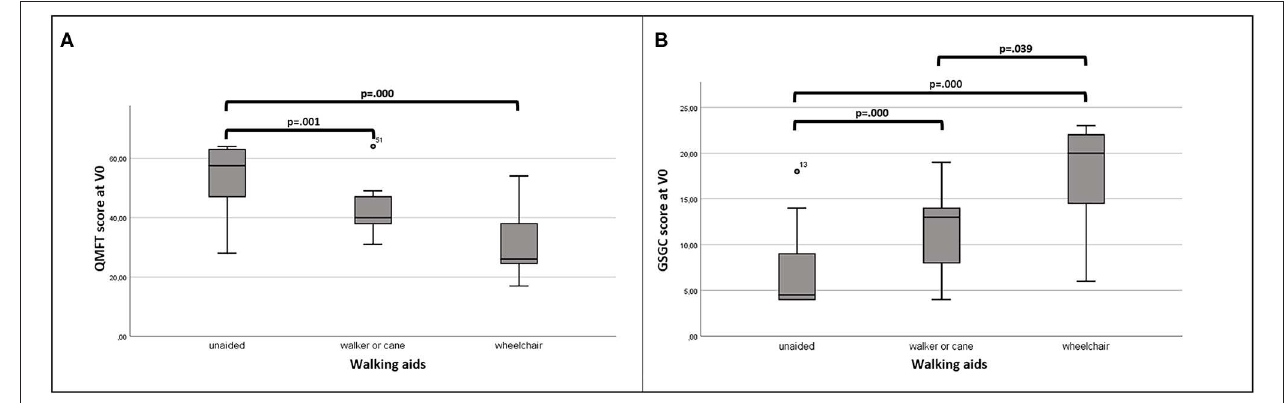
FIGURE 2 | Discrimination validity of QMFT (A) and GSGC (B) .